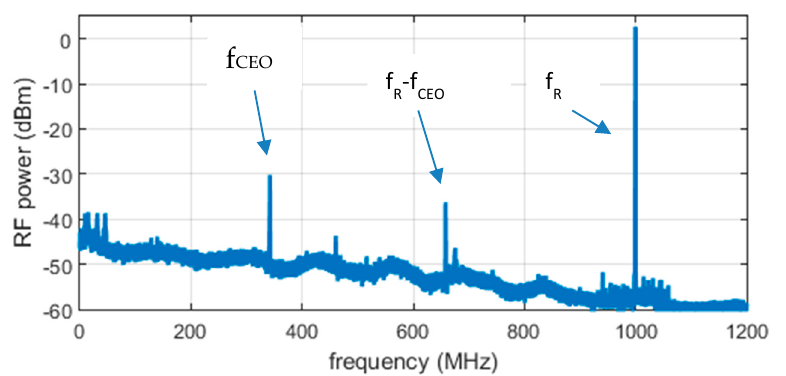
Figure 20. Schematic setup of the f-2f interferometer.